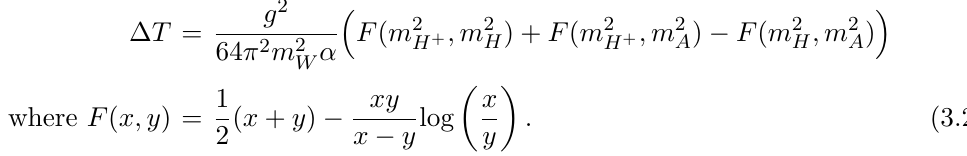
Figure 1 . Figure showing representative one-loop Feynman diagrams [53] for the H trilinear vertex. Here, (cid:30) is used to denote h; H; A; H + ; G 0 ; G + or a subset that preserves the Z 2 symmetry (even number of particles from (cid:8) 2 ) in each